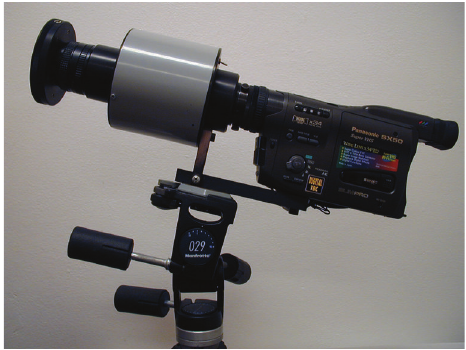
Figure 2: Current device used on both stations in Kunˇzak and Ondˇrejov S-VHS camcorder equipped with image intensifier and wide-field lens.